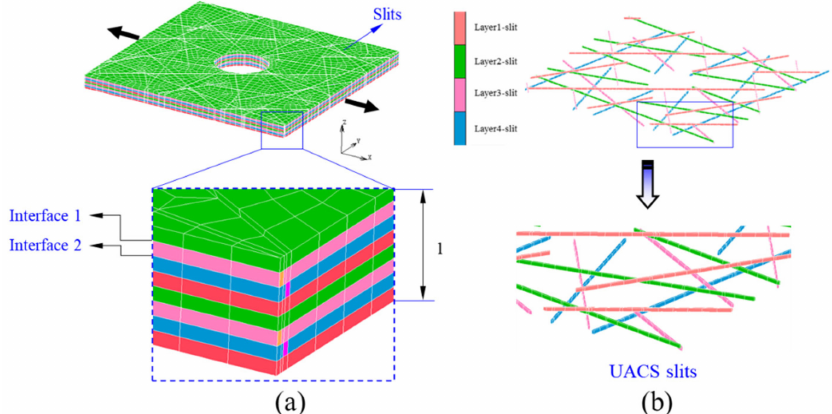
Figure 6. Model for the notched UACS laminate: ( a ) the overall structure of the model, ( b ) detail distribution of